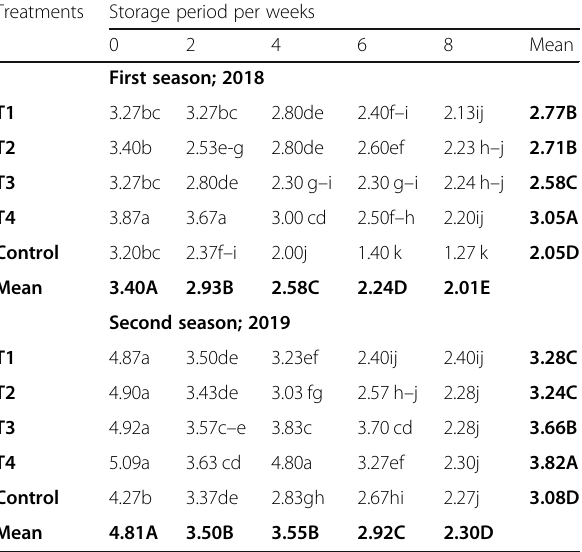
Table 2 Effect of preharvest spraying with moringa leaf extract, boric acid, and chelated calcium on firmness (Lb/inch 2 ) of Hollywood plum fruits stored at 0 ± 1 °C and RH 85 – 90% during 2018 and 2019 seasons